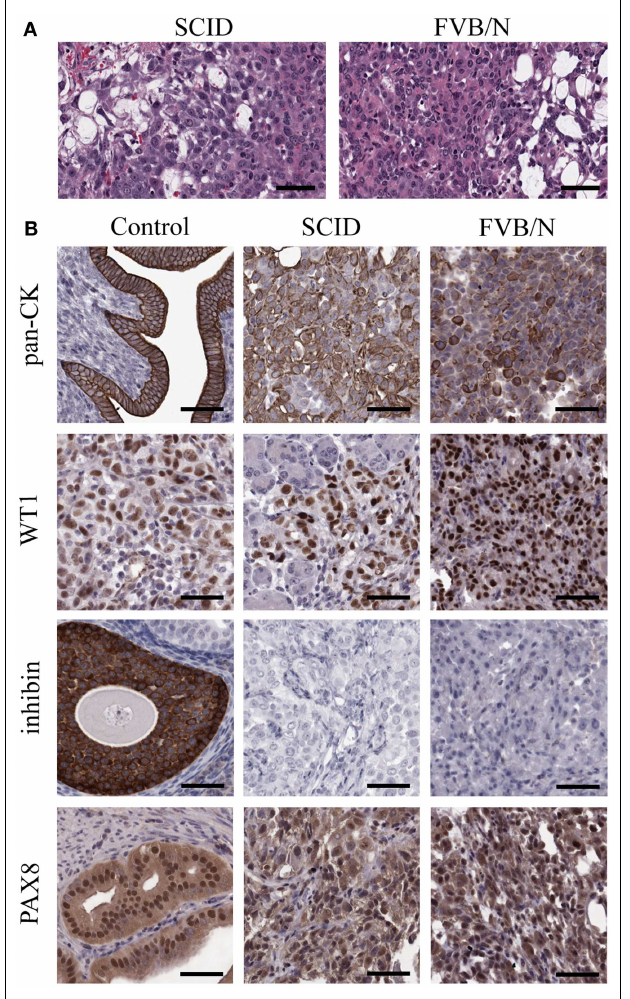
FIGURE 4 | STOSE produce high-grade serous epithelial tumors in both SCID and syngeneic FVB/N mice. Tumors were fixed in formalin and set in paraffin blocks; 5 µ m sections were used for immunohistochemistry on SCID and FVB/N STOSE cell-derived tumors. (A) Hematoxylin and eosin staining of STOSE cell-derived tumors. Scale bars = 100 µ m. (B) Detection of the epithelial tumor marker, cytokeratin is presented with uterus as a positive control.Wilms tumor-1 (WT1) is a marker of HGSC and is shown with a human high-grade serous ovarian carcinoma as a control. Detection of the granulosa cell and sex-cord stromal tumor marker, inhibin, is shown with granulosa cells as a positive control. PAX8 expression is shown with a fallopian tube (oviduct) positive control. Scale bars = 50 µ m.